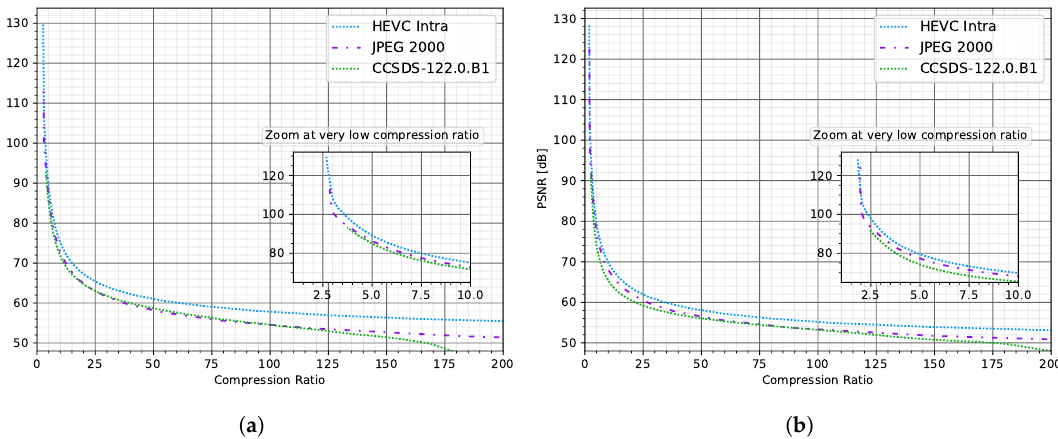
Figure 6. Average Peak Signal-to-Noise Ratio (PSNR) vs. compression ratio performance of the proposed High Efficiency Video Coding (HEVC), baseline JPEG 2000, and the Consultative Committee for Space Data Systems (CCSDS) 122.0.B1 standard, over: ( a ) Landsat-8 and ( b ) Sentinel-2A/B part of the dataset described in Figure 2 and Table 1. Table 4. Achieved compression ratios (CR) at the same level of PSNR. Performance of HEVC is expressed relative to JPEG 2000 and CCSDS 122.0.B1 CRs over two parts of the proposed